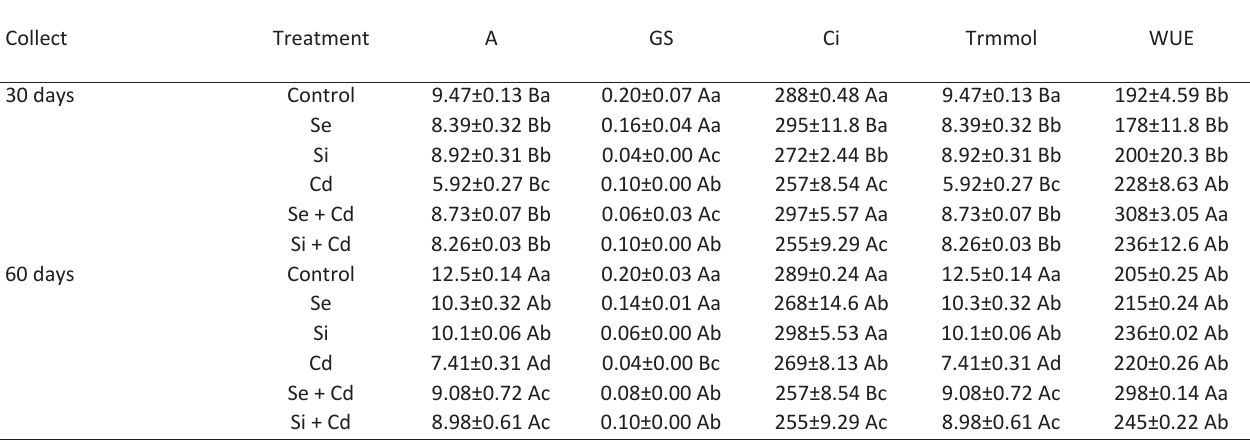
Different lowercase letters indicate significant differences between treatments in same collect. Different upper case letters indicate significant differences between collects for same